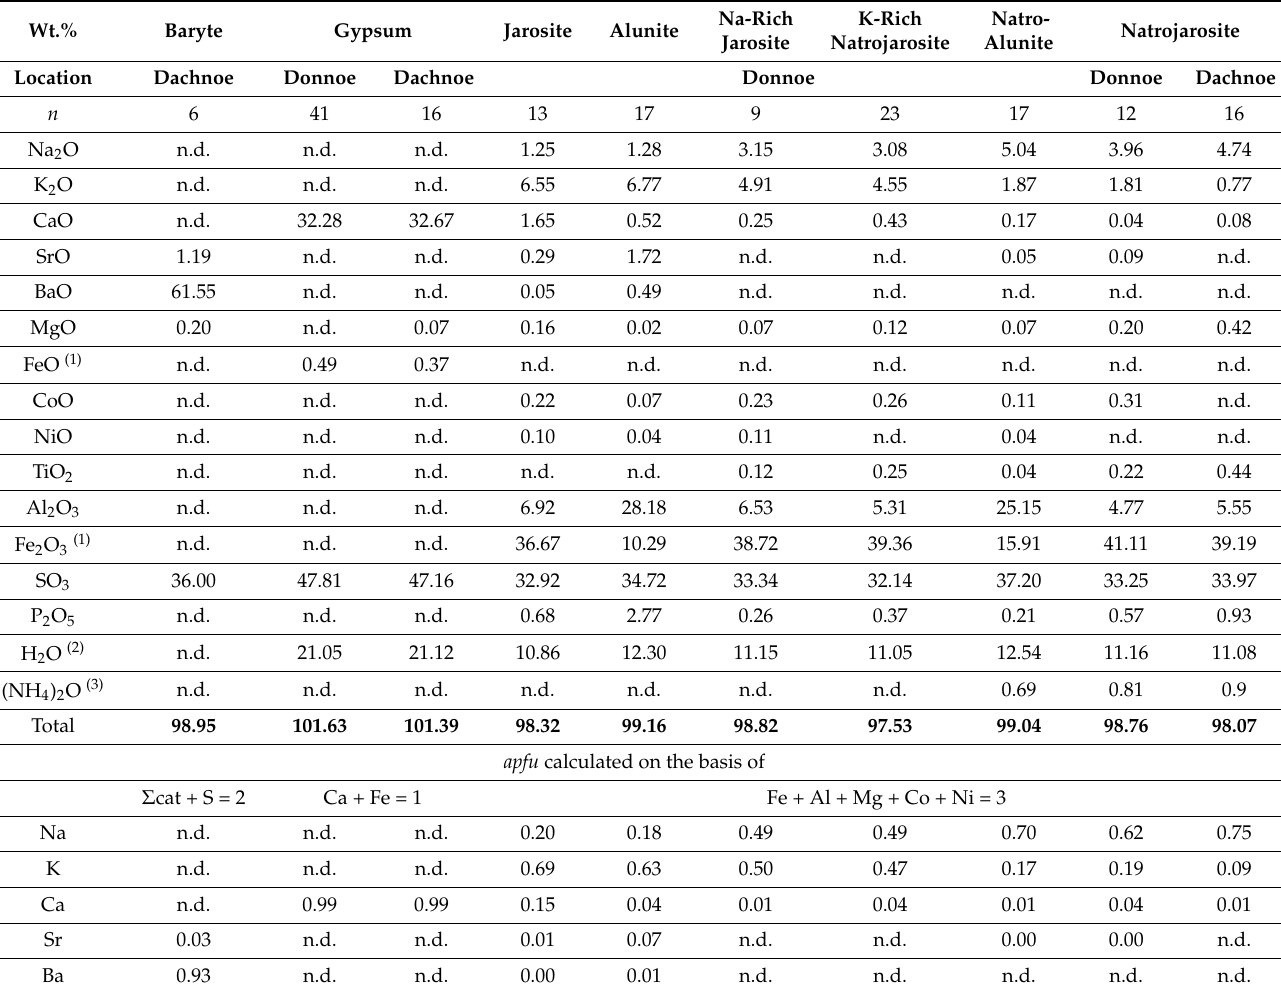
Table 2. Chemical composition of baryte, gypsum, and alunite supergroup minerals: jarosite, alunite, natrojarosite and